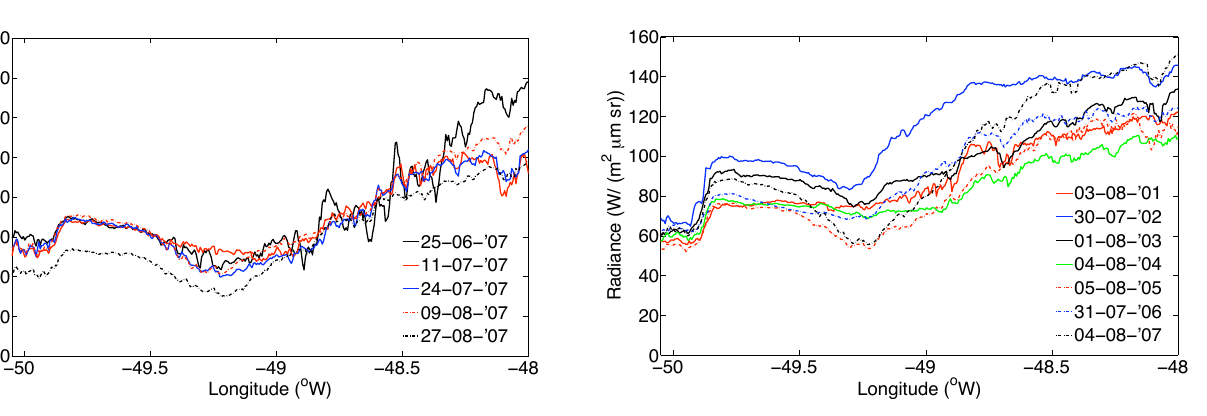
Fig. 4. Radiance profiles for different years, averaged between 67.75 ◦ N to 68 ◦ N, from MODIS